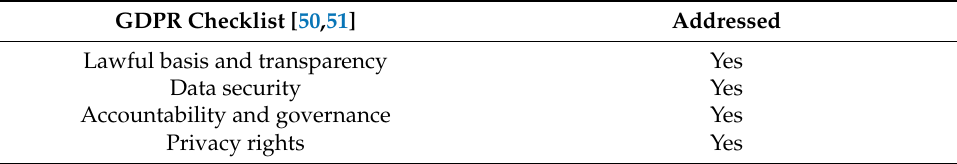
Table 14. GDPR compliance checklist for SSK.